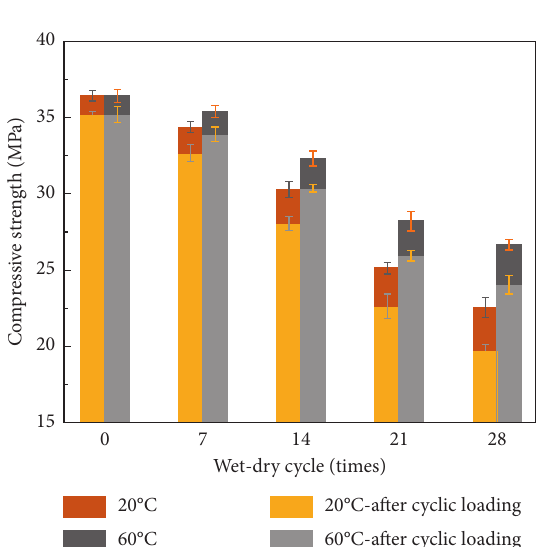
Figure 4: Compressive strength under different wet-dry